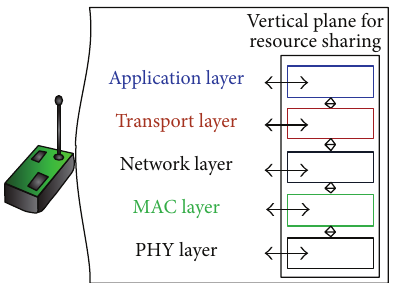
Figure 3: Manager method information sharing (redrawn from [14,